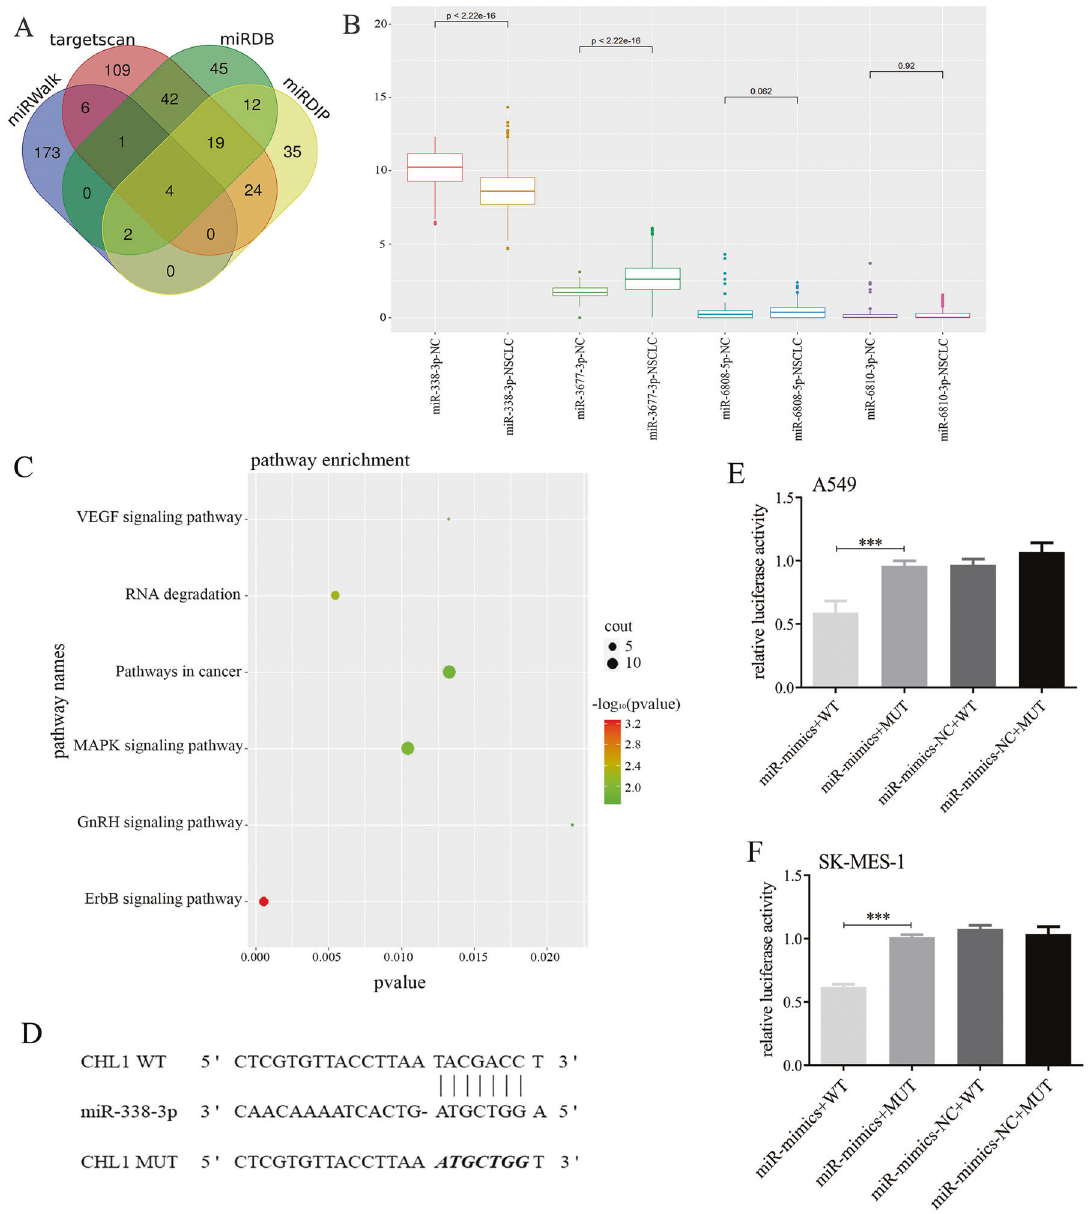
Fig. 3 CHL1 is a direct target gene of miR-338-3p. A Venn diagram of target microRNAs from Targetscan, miRWalk, miRDB, and mirDIP. B The expression levels of target miRNAs in the TCGA-NSCLC cohort. C The pathway bubble diagram of miR-338-3p. D The binding seed sequence of miR-338-3p and CHL1 3 ʹ UTR. E The dual luciferase reporter gene assays of miR-338-3p and CHL1 in A549 cells. F The dual luciferase reporter gene assays of miR-338-3p and CHL1 in SK-MES-1 cells. *** P < 0.001. Fig. 6K: P < 0.001), further demonstrated that exosomal miR-338-3p could reduce the expression of CHL1 in NSCLC. Exosomal miR-338-3p regulates tumor cells proliferation and apoptosis To verify the role of exosomal miR-338-3p in NSCLC, A549 cells and SK-MES-1 cells were co-cultured with exosomes from BEAS-2B cells transfected with miR-338-3p mimics and mimics-NC. MTS results showed that the growth rates of cells with higher exosomal miR- 338-3p expression were lower (Fig. 7A: A549: P < 0.001; Fig. 7B: SK- MES-1: P < 0.001). Apoptotic assay results showed that the apoptotic rates of cells with elevated exosomal miR-338-3p expression were higher than the control groups (Fig. 7C: A549: P < 0.001; Fig. 7D: Cell Death and Disease (2021)